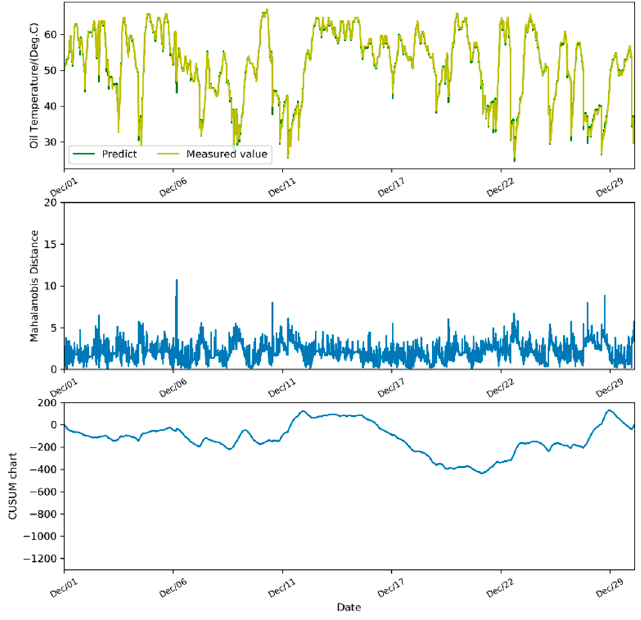
Figure 9. Testing normal behavior model results for Turbine #149.